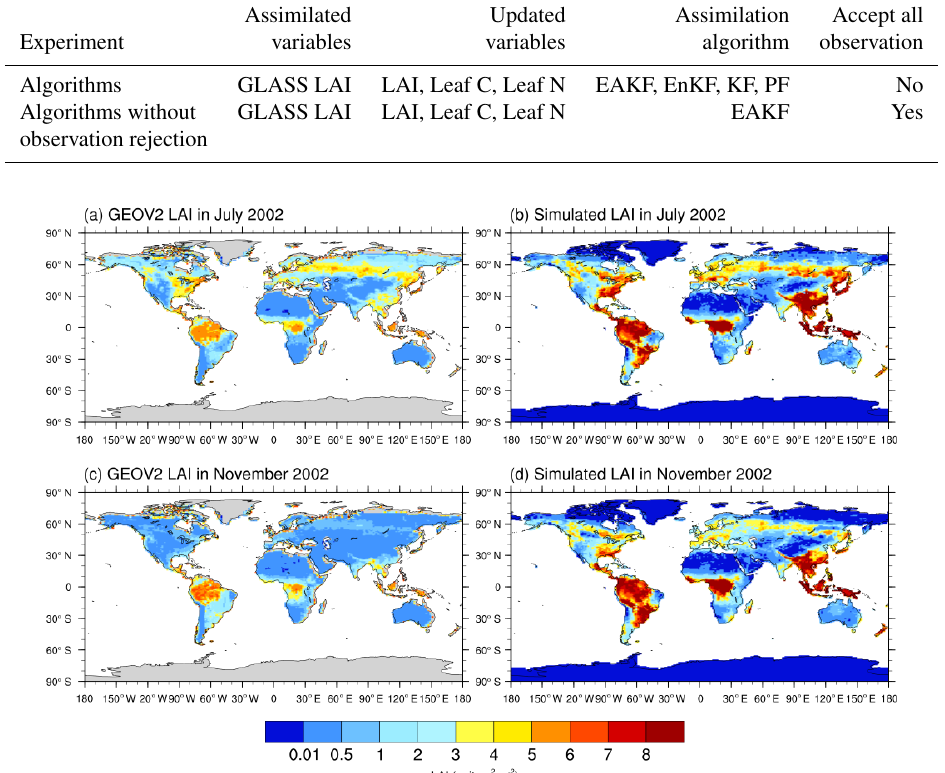
Figure 1. Spatial distributions of global LAI values in 2002 for (a) GEOV2 LAI in July, (b) ensemble mean of simulations in July, (c) GEOV2 LAI in November, and (d) ensemble mean of simulations in